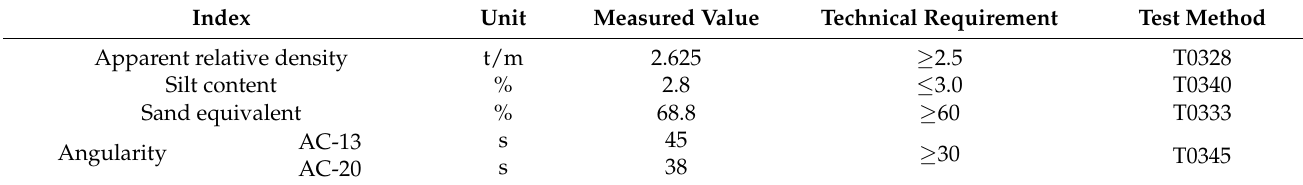
Table 6. Fine aggregate for asphalt